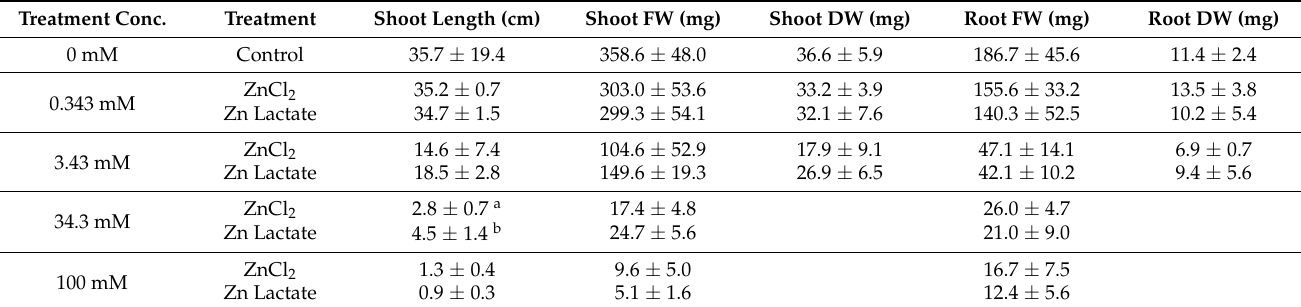
Table 1. Plant growth parameter results for zinc (Zn) treatments. After 13 days of growth, wheat seedlings were harvested, and shoot length was measured along with fresh weight (FW) and dry weight (DW) of both root and shoot tissue. A t -test was used to identify differences between zinc chloride and zinc lactate treatments within each treatment level for each plant growth parameter, where superscripts “a” and “b” denote treatment differences of p < 0.05. ± : standard deviation. Treatment Conc.